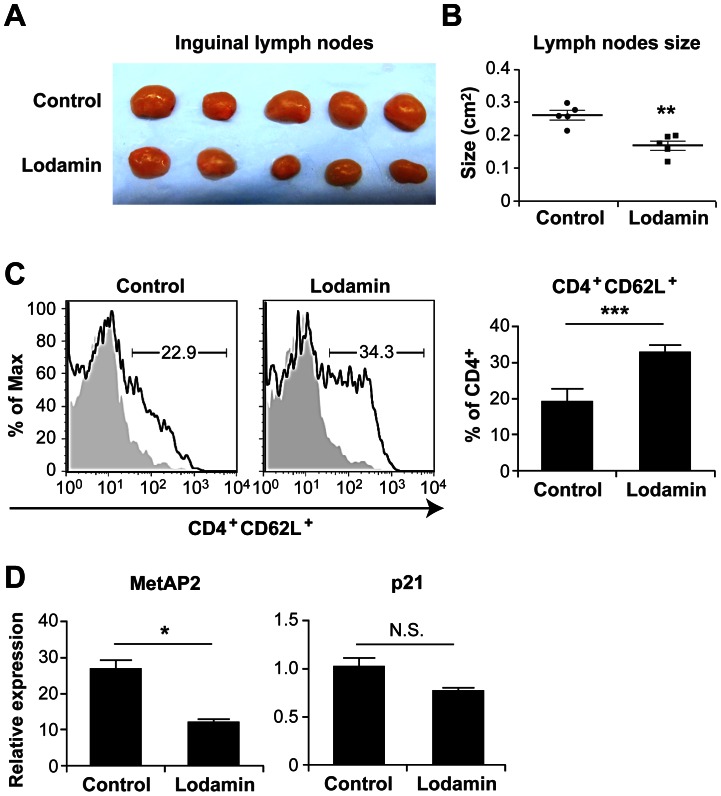
Reduced size of lymph nodes in Lodamin administered mice.On day 21 post IRBP1–20 immunization, lymph nodes from control vehicle-administered mice and Lodamin treated mice were collected. (A) images of lymph nodes removed at day 21. (B) volume of inguinal lymph nodes calculated with two parameters; (width)2×(length)×0.52. (C) diagrams (left) and statistics (right, mean ± SEM, n = 5, ***p<0.001)) of FACS analysis of cell surface CD4+CD62L+ expression of single cell suspension from lymph nodes. (D) MetAP2 expression and p21 expression as evaluated by qPCR from purified lymph nodes CD4+ T cells, (n = 5, *p<0.05) values represent means ± SEM.